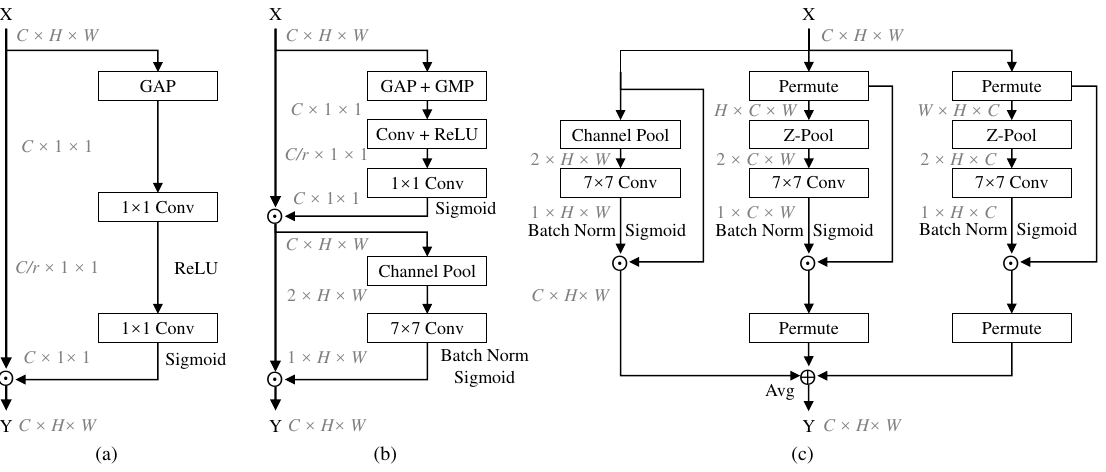
Figure 1. Comparisons with different attention modules [13]: ( a ) squeeze excitation (SE) module; ( b ) convolutional block attention module (CBAM); ( c ) triplet attention (TA). ⊕ denotes broadcast elementwise addition, and (cid:12) denotes broadcast elementwise